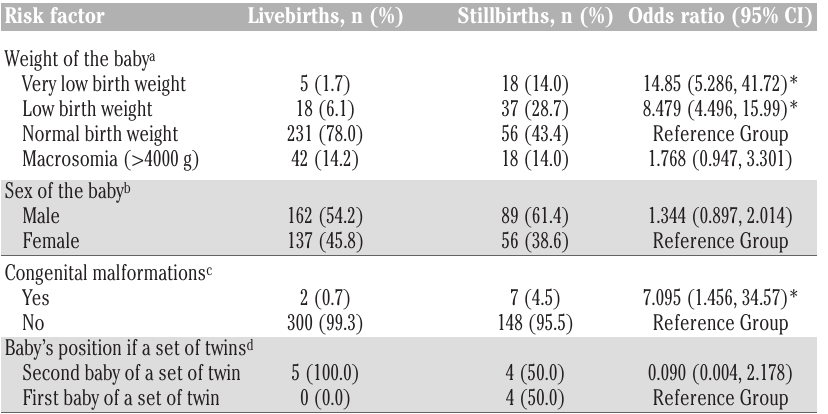
Table 5. Causes of death among all still- births (Aberdeen classification).